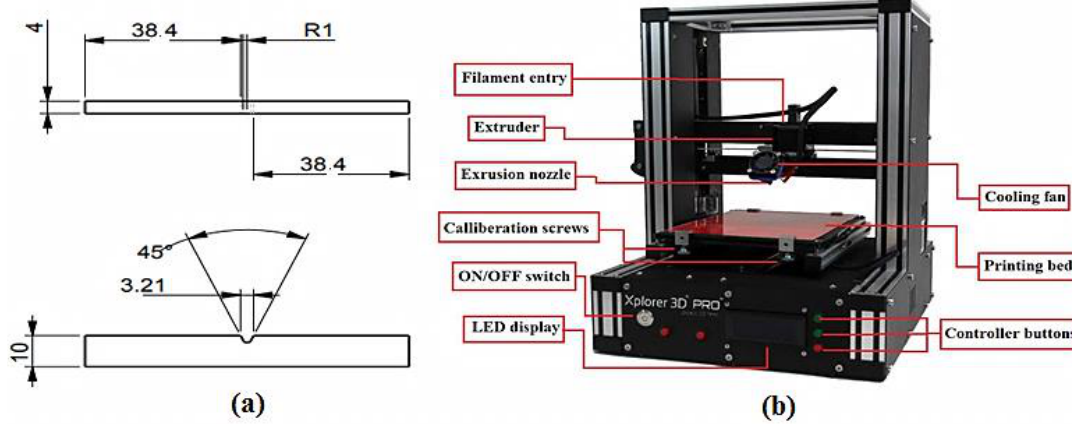
Figure 1. ( a ) Standard sample for impact testing ( b ) Xplorer 3D Pro.